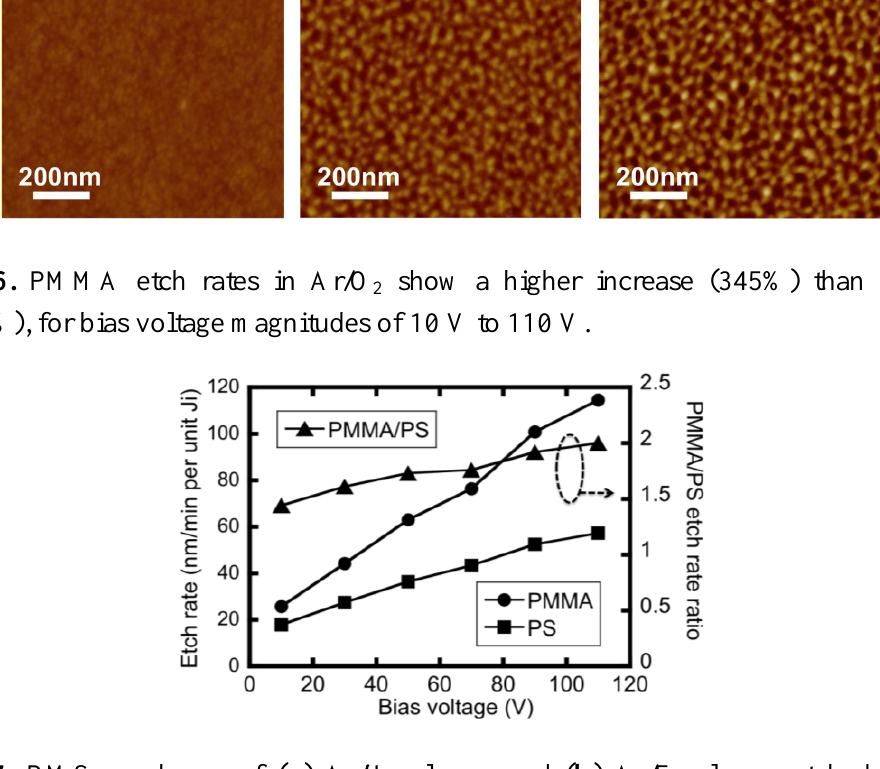
plasma and ( b ) Ar/F plasma etched PS films 2 2